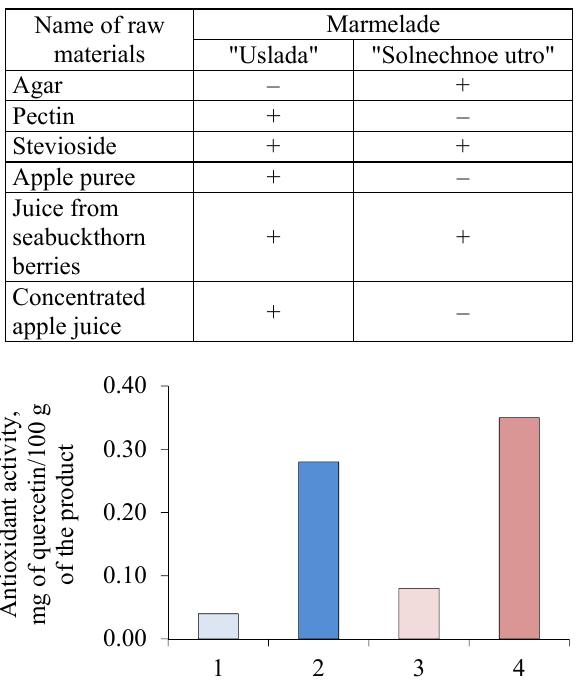
Table 4. Formulation of marmalade